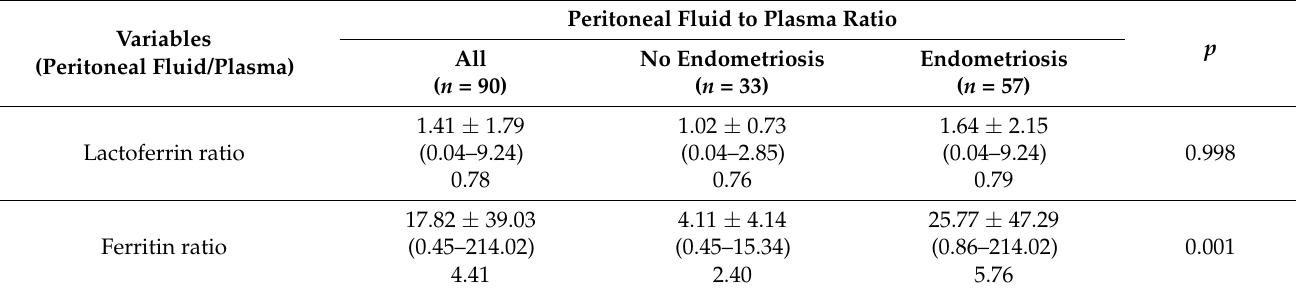
Table 6. Comparison between ratios of peritoneal fluid variables’ concentrations to plasma for the whole group and in regard to the presence of